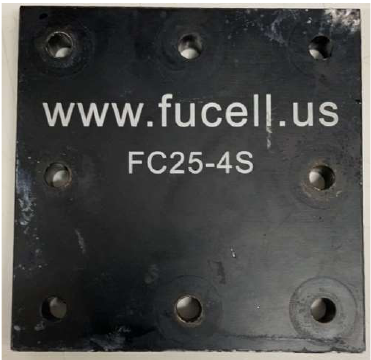
Figure 13. End plate.